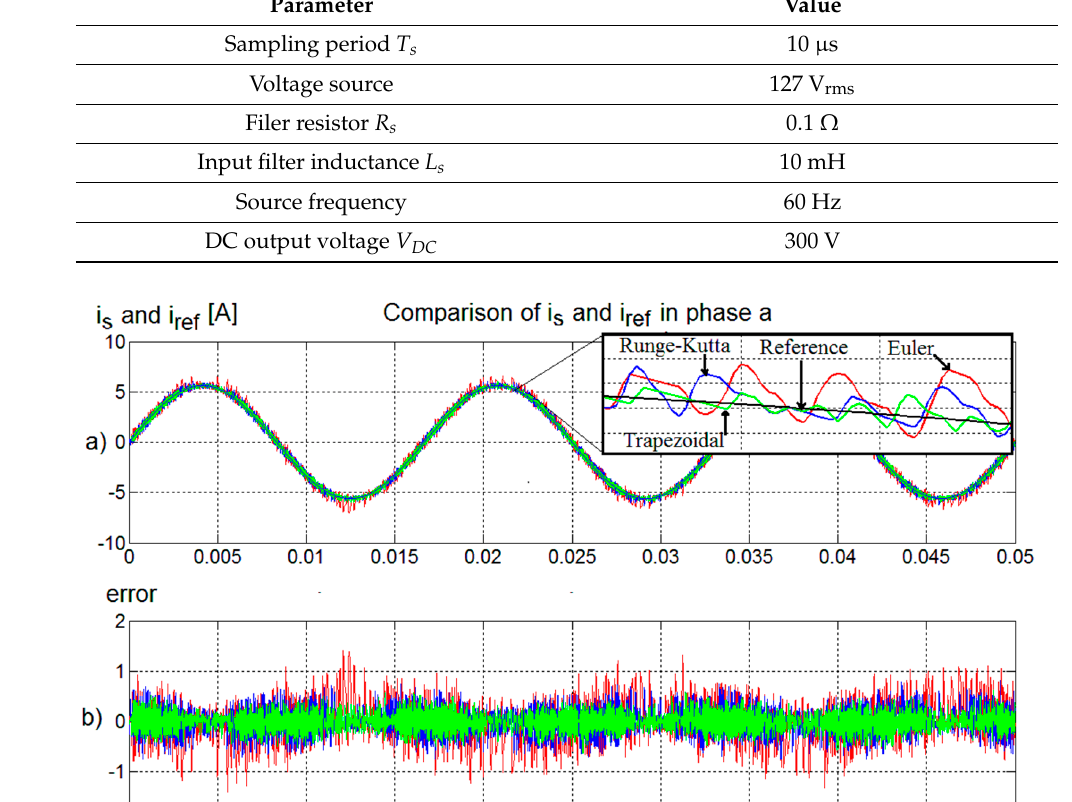
Table 2. T Simulation parameters.